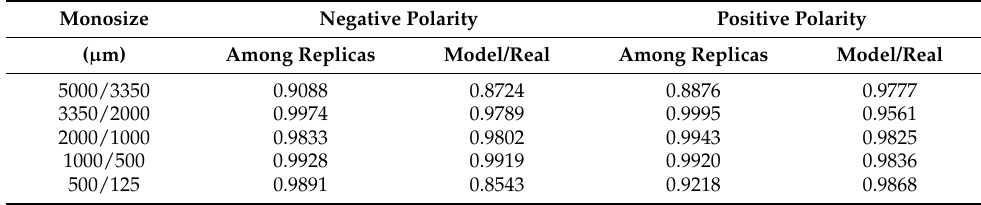
Table 6. F-test values obtained in the comparisons performed.